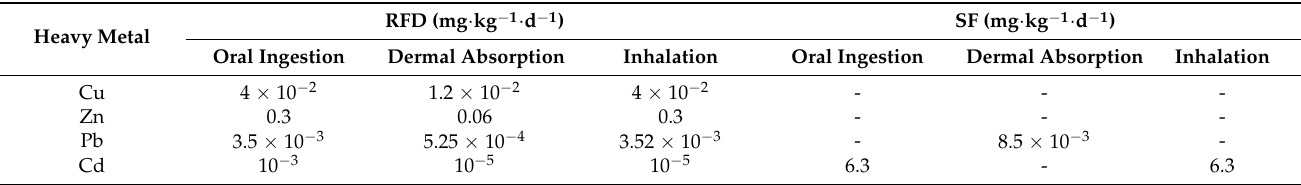
Table 3. RFD and SF values for different heavy metal exposure routes.